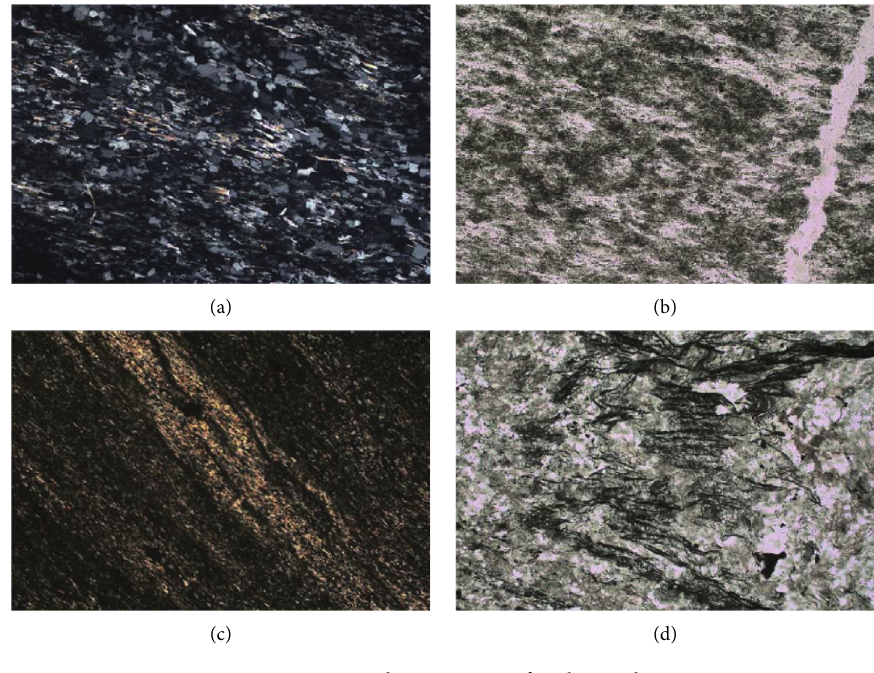
Figure 4: Microcharacteristics of rock samples.